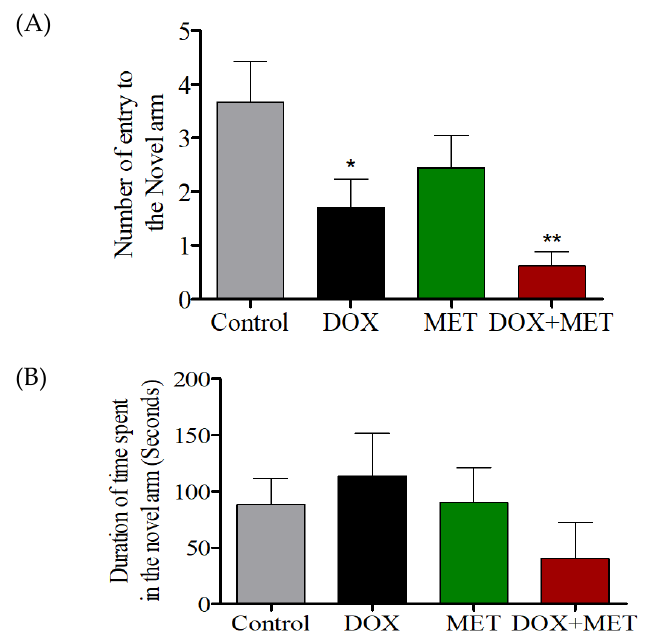
Figure 2. ( A ) Effects of DOX and MET on the number of entries into the novel arm in the Y-maze test. ( B ) Effects of DOX and MET on the total time spent in the novel arm in the Y-maze test.